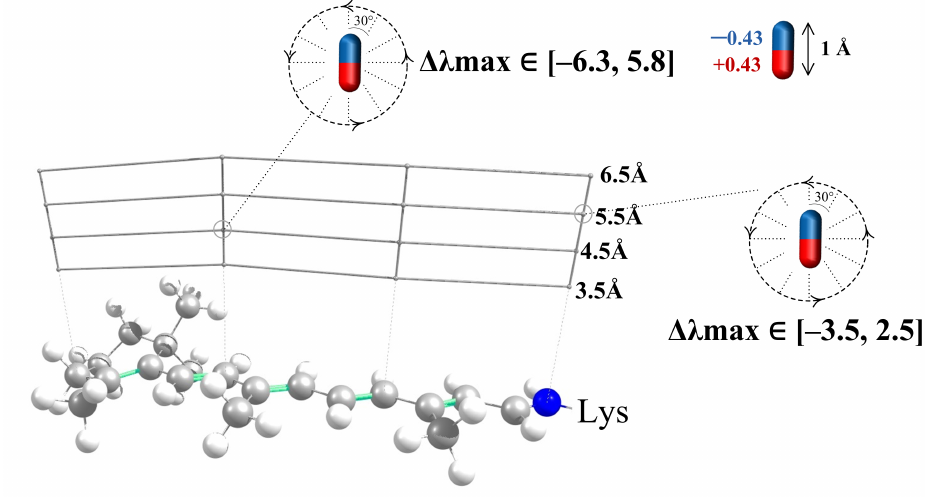
Figure 4. Grid representing the positions of a dipole moment relative to the all-trans PSB. At each grid point, we performed the ab initio calculation of ∆ λ max values for different orientations of the dipole moment relative to the chromophore axis.